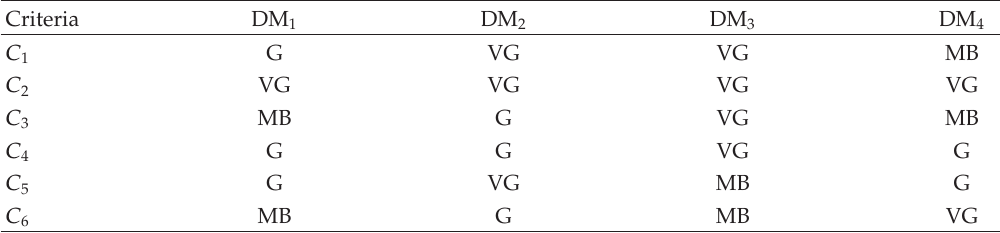
Table 6: The importance weight of the